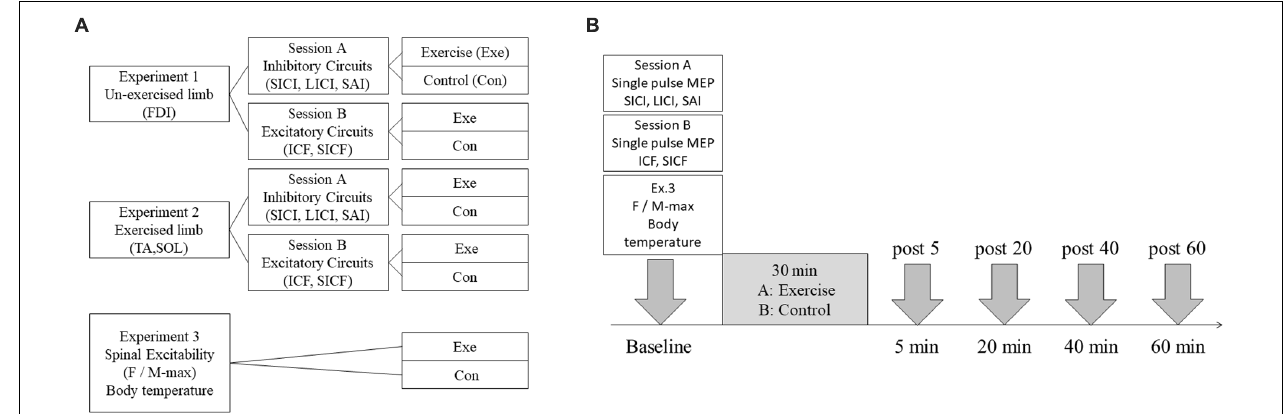
FIGURE 1 | Experimental overview. (A) Experimental session. Intracortical circuits in the M1 non-exercised hand and leg areas were measured in Experiments 1, 2, respectively. Spinal excitability in the hand and leg was measured in Experiment 3. In Experiments 1, 2, intracortical inhibitory circuits were assessed by measuring short- and long-interval intracortical inhibition (SICI and LICI), and SAI in session A. Intracortical excitatory circuits were assessed by intracortical facilitation (ICF) and short-interval intracortical facilitation (SICF) in session B. All experiments consisted of exercise and control conditions. Participants performed 30 min of low-intensity aerobic exercise on the recumbent ergometer in exercise conditions, and rested while seated on the recumbent ergometer in control conditions. (B) Experimental protocol. In Experiments 1, 2, transcranial magnetic stimulation (TMS) assessments were performed before exercise and 5, 20, 40, and 60 min after 30 min of exercise. In Experiment 3, the F-wave and M-max were measured at the same timing as in Experiments 1, 2. TABLE 1 | Baseline transcranial magnetic stimulation and electric stimulation parameters. RMT (%MSO) AMT (%MSO) Test intensity (%MSO) ES intensity (mV)